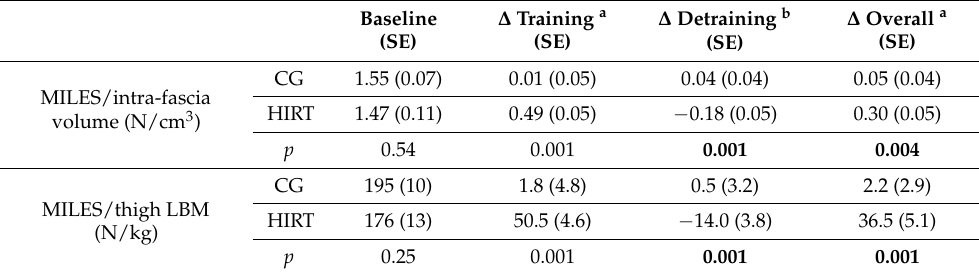
Table 2. Baseline values and mean changes ± standard error (SE) of muscle quality (MILES/intra- fascia volume and MILES/thigh mass) as determined by MRI and DXA in the HIRT and CG after training and